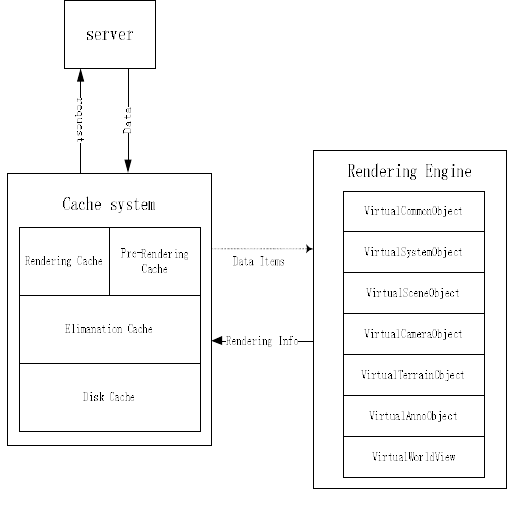
Figure 6. experiment system over